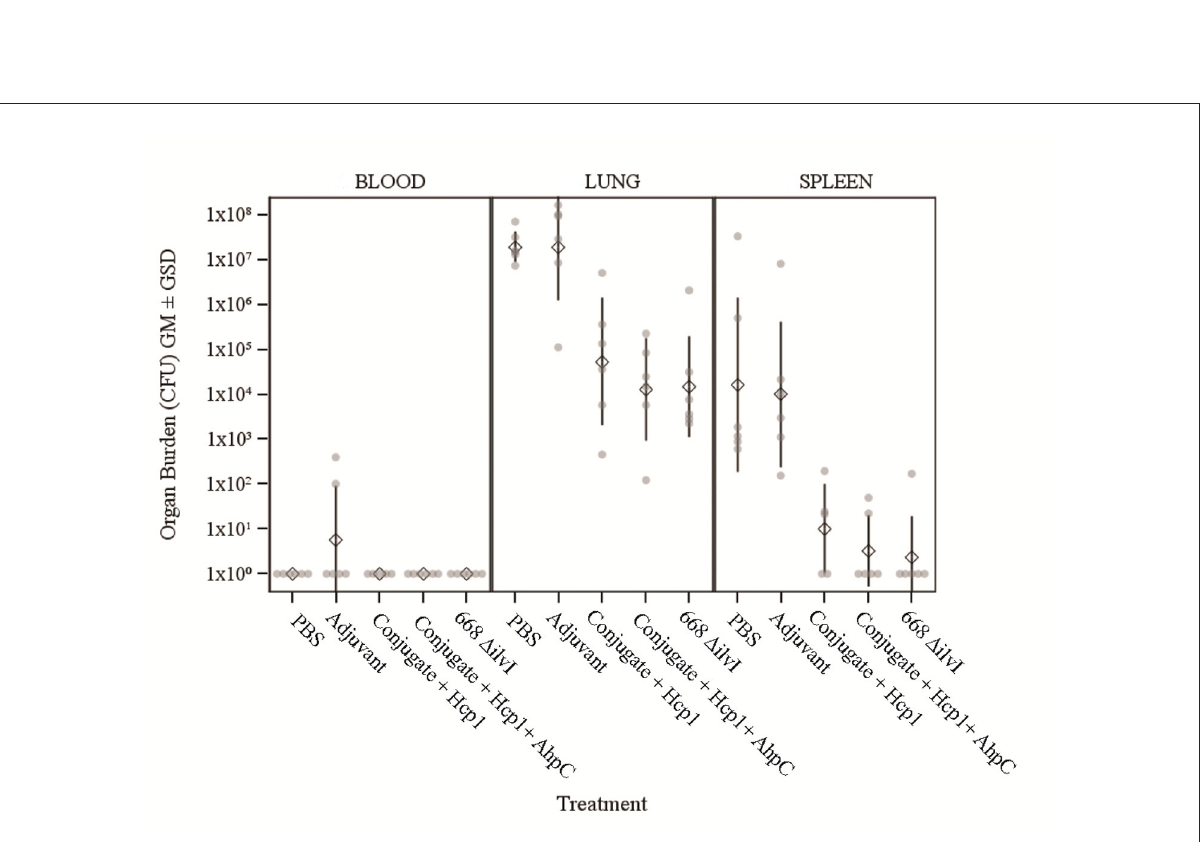
FIGURE3 The recovery of bacteria as determined by CFU from blood, spleens and lungs of C57BL/6 mice 3 days post-challenge with Bp K96243. The samples were from six mice/group. The left axis represents CFU/ml (blood) or CFU/g (lung and spleen). The individual points represent one animal, and the baseline points indicate the remaining survivors with no detectable CFU. The diamond-shaped symbol and vertical line are the geometric mean and standard deviation, respectively. The limits of detection were 100 CFU/ml blood and 5 CFU/g spleen or lung